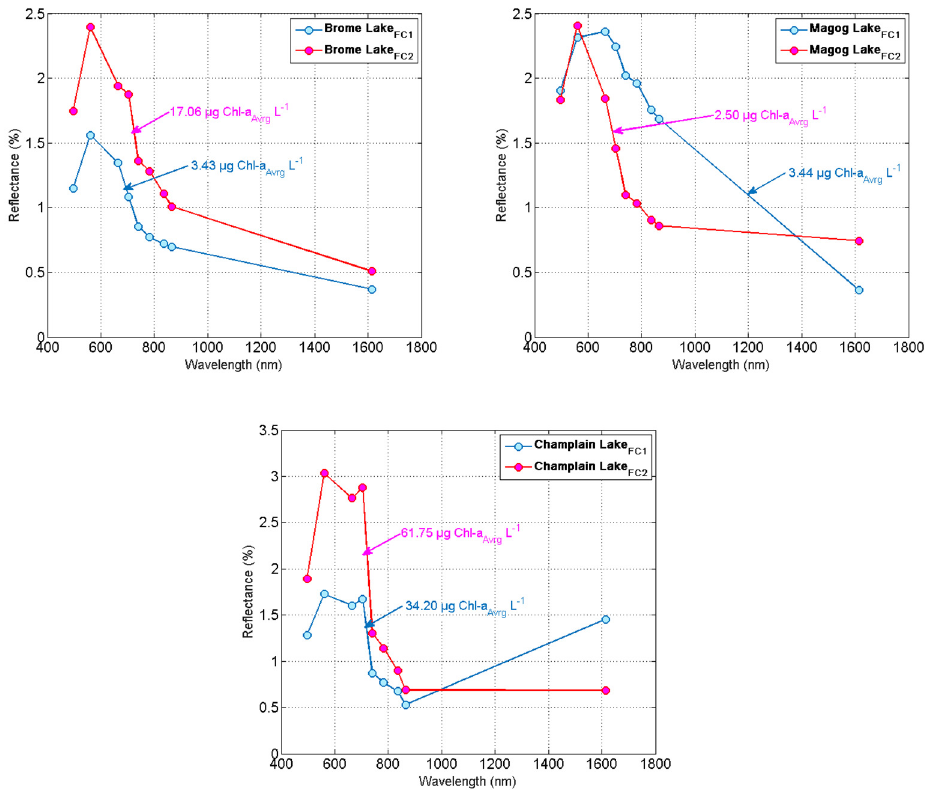
Figure 7. Averages of the reflectance of the Sentinel-2-simulated bands for the two field campaigns (FC1 and FC2) with averages of in situ chlorophyll-a.